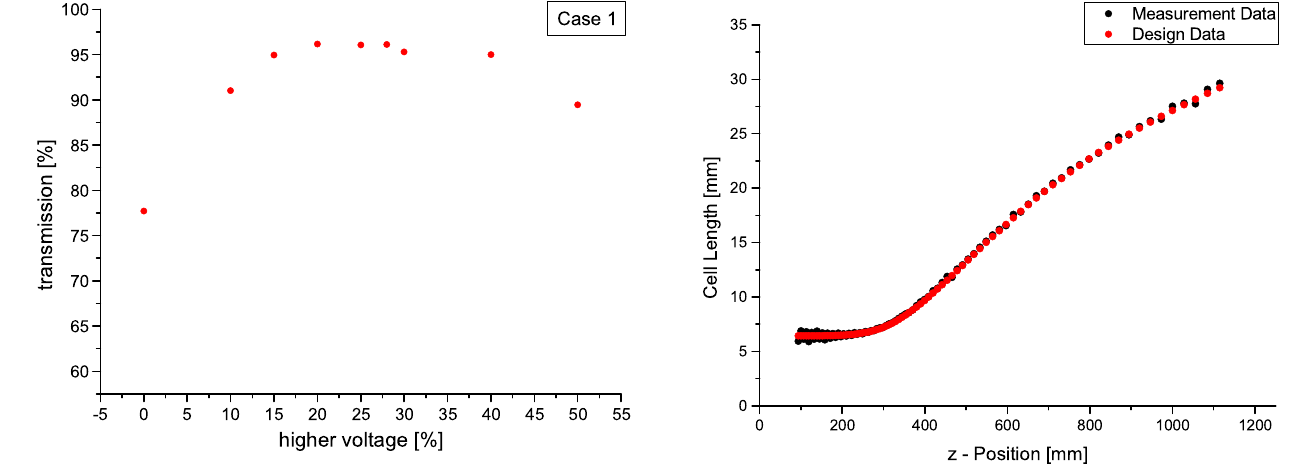
FIG. 17. Comparison of the machining data for the cell length (red) and its measurement (black). The differences between both are